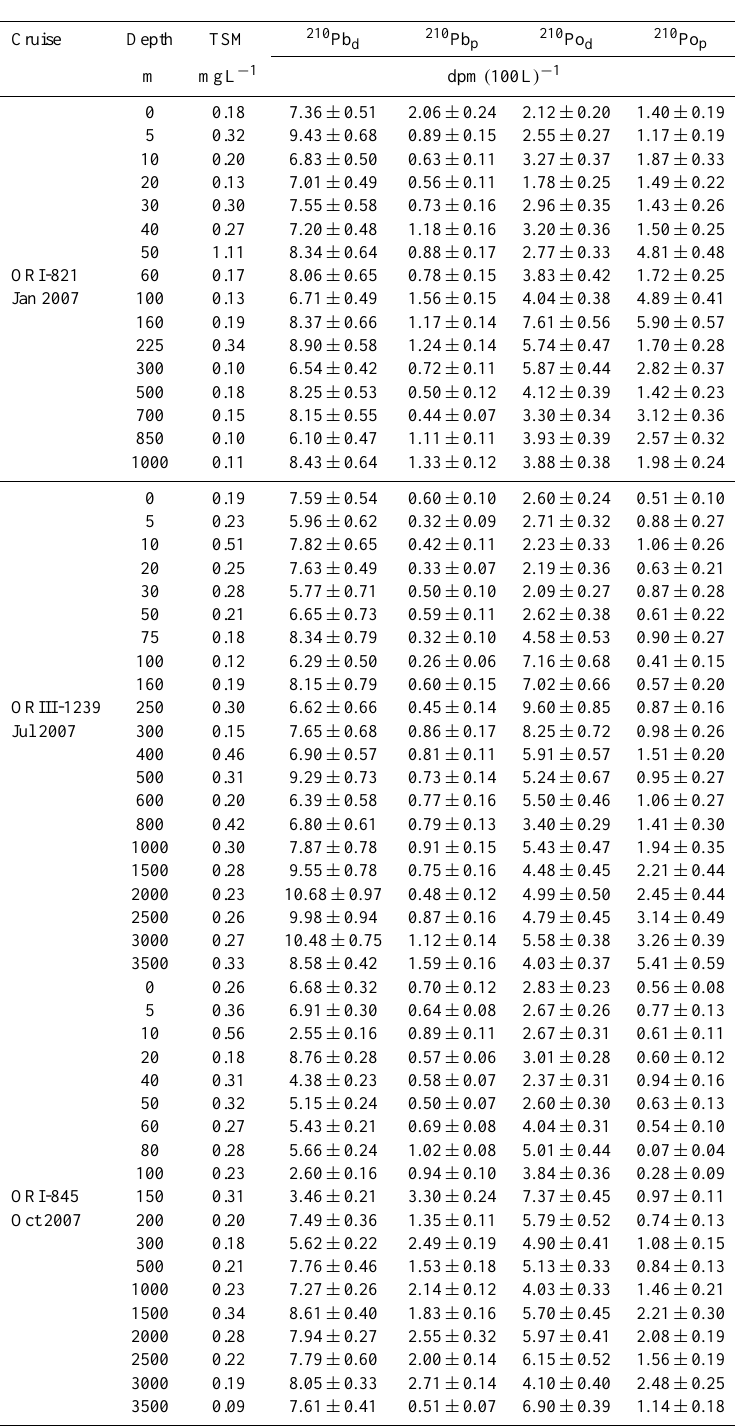
Table A1. Depth, total suspended matter (TSM) concentration, dissolved ( 210 Pb d ) and particulate ( 210 Pb p ) 210 Pb, and dissolved ( 210 Po d ) and particulate ( 210 Po p ) 210 Po measured from different cruises to the SEATS station. Standard deviations of radionuclide data are based on counting error (1 σ